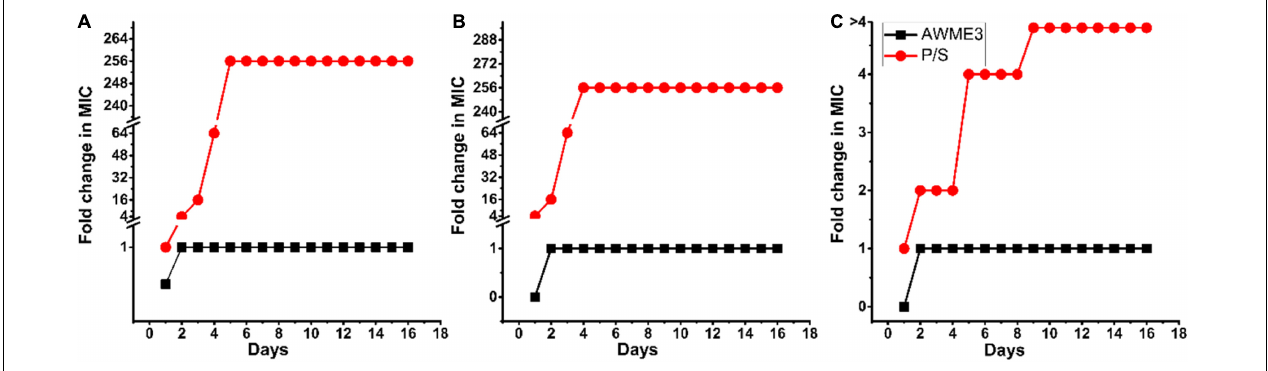
FIGURE 4 | Klebsiella pneumoni ae strains resistance assessment. Resistance acquisition monitored during 16 serial passages (16 days) in the presence of sub-MIC (0.5 × MIC) of AWME3, and positive control (P/S) for (A) K. pneumoniae KPi1627, (B) K. pneumoniae KPM9, and (C) K. pneumoniae ATCC BAA-2473. The Y-axis represents the highest bacterial concentration during cell passaging. The figures are representative of three independent experiments.